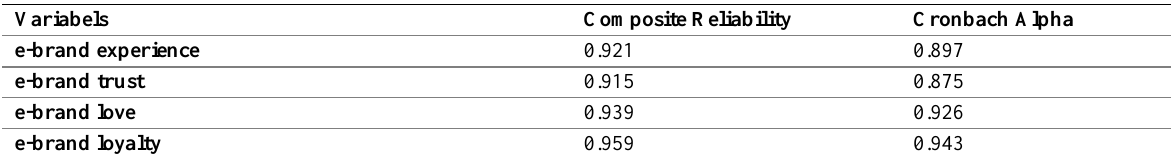
Table 1: Cronbach Alpha, Composite